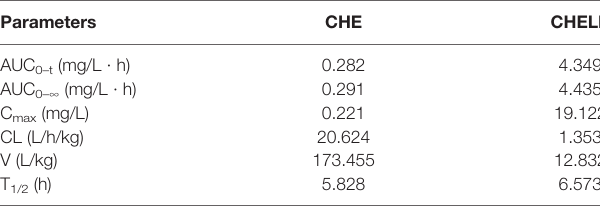
TABLE 8 | Pharmacokinetic parameters of CHE and